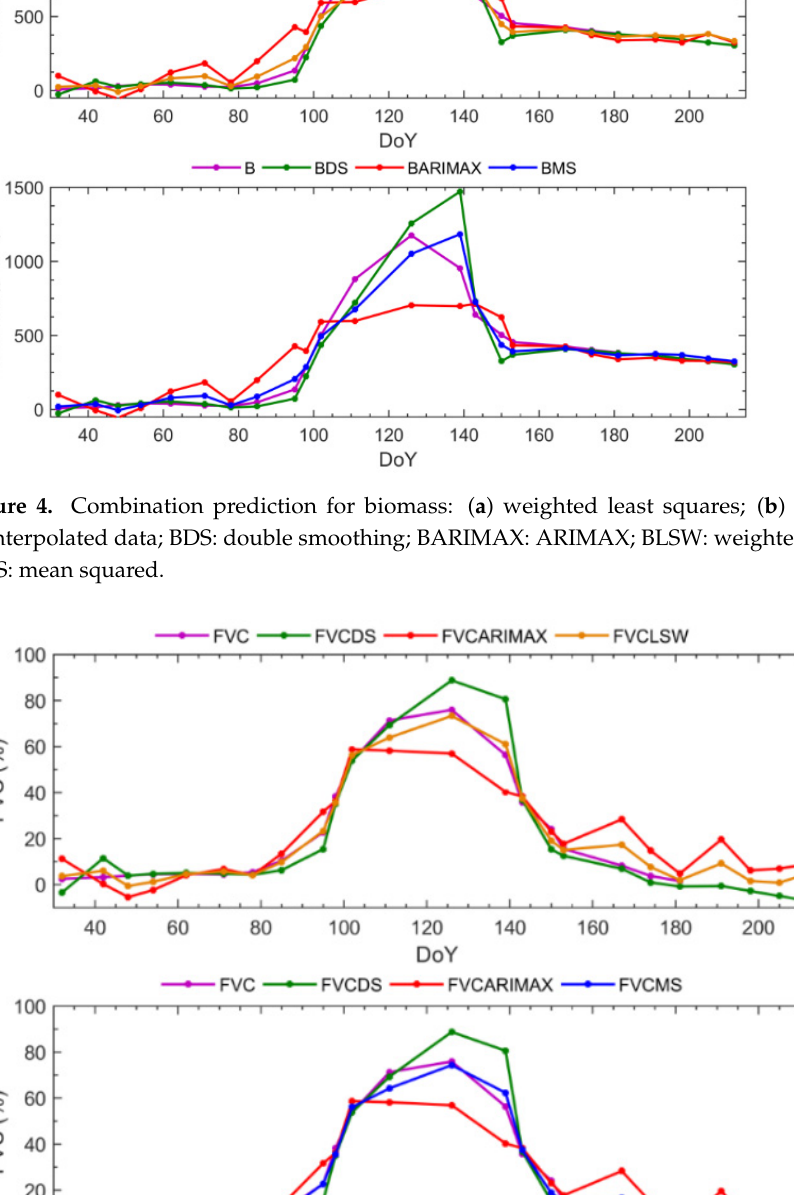
Figure 5. Combination prediction for FVC: ( a ) weighted least squares; ( b ) mean squared. FVC: interpolated data; FVCDS: double smoothing; FVCARIMAX: ARIMAX; FVCLSW: weighted least squares; FVCMS: mean squared.